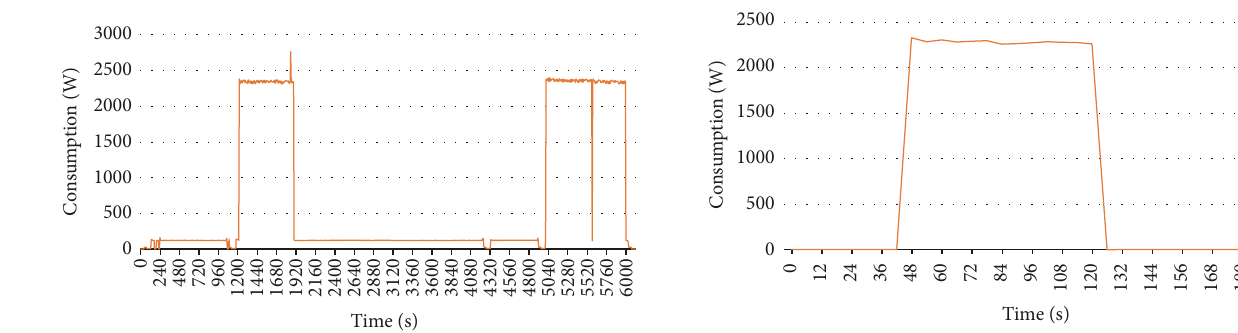
Figure 13: Dishwasher activation period.